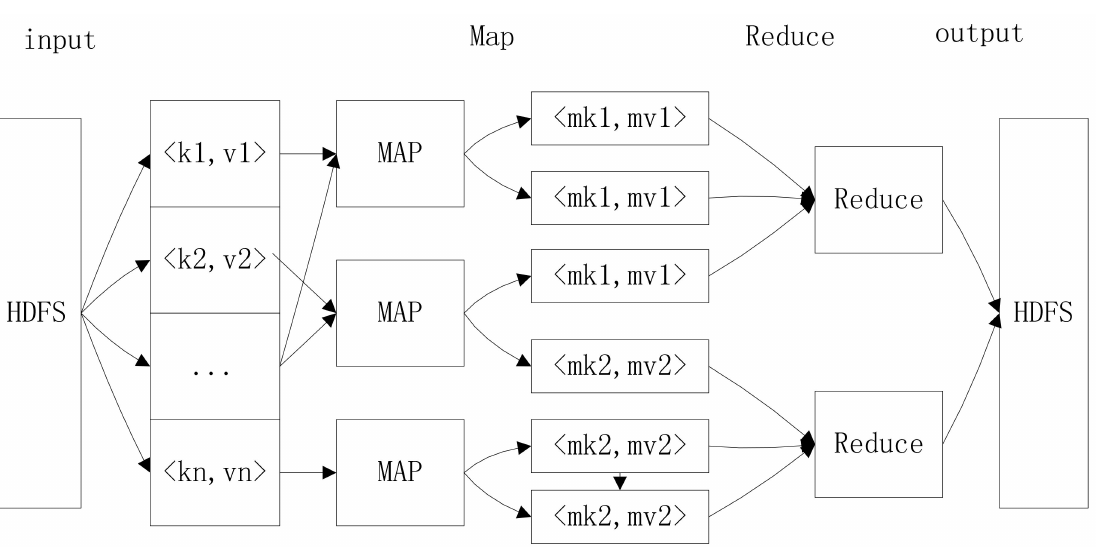
Figure 3. Diagrammatic layout of map/reduce. MAP: the mapping process of hadoop; HDFS: hadoop distributed file